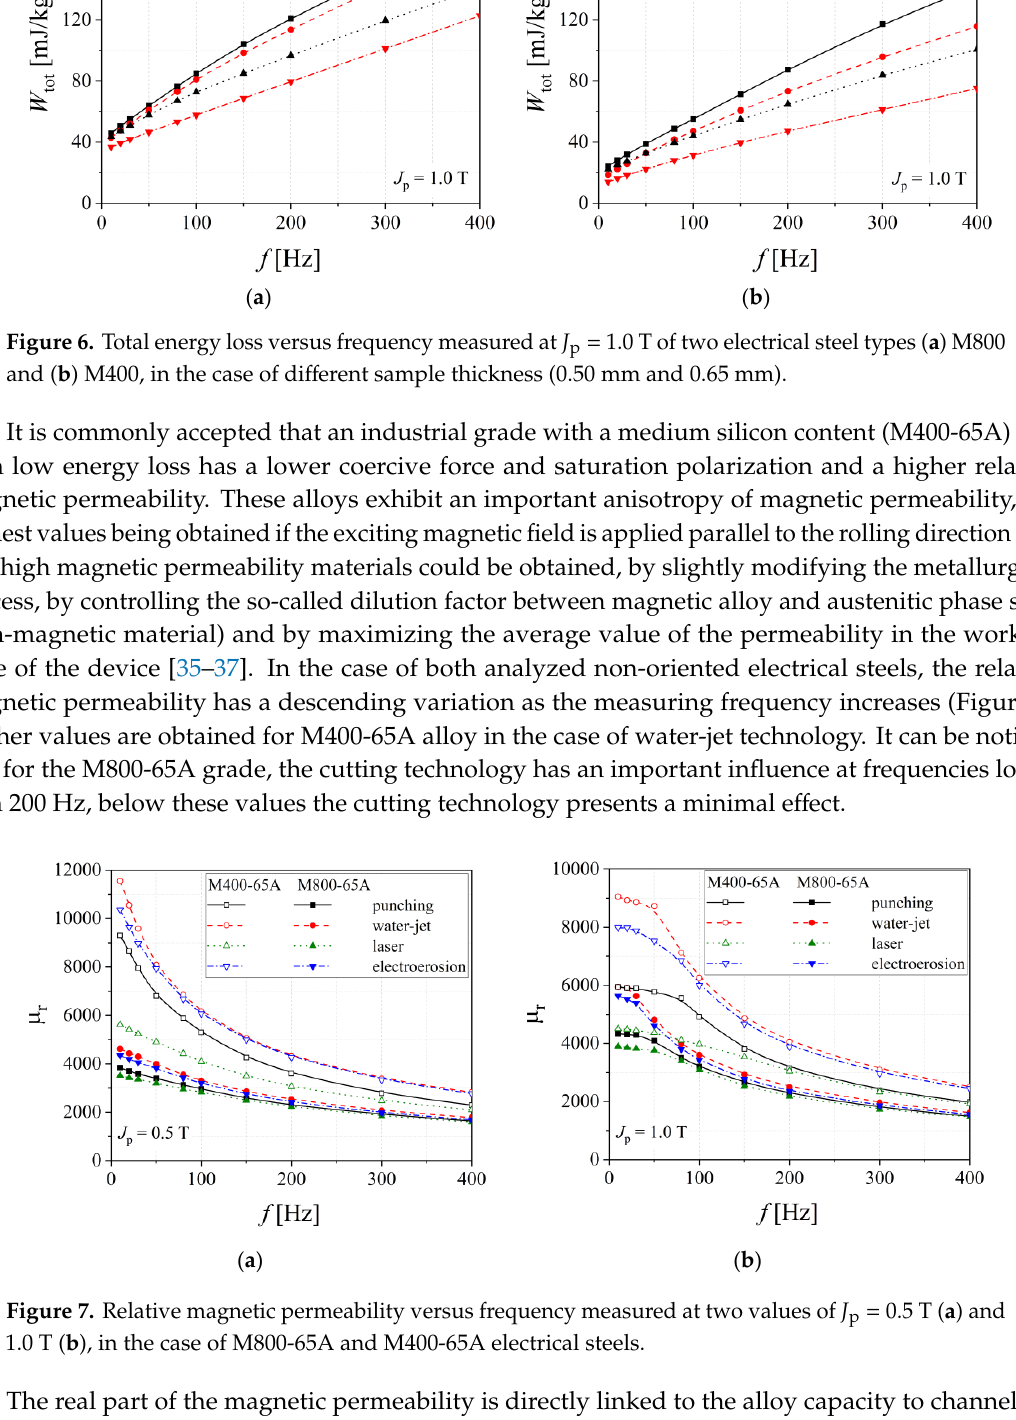
Figure 7. Relative magnetic permeability versus frequency measured at two values of J p = 0.5 T ( a ) and 1.0 T ( b ), in the case of M800-65A and M400-65A electrical steels.